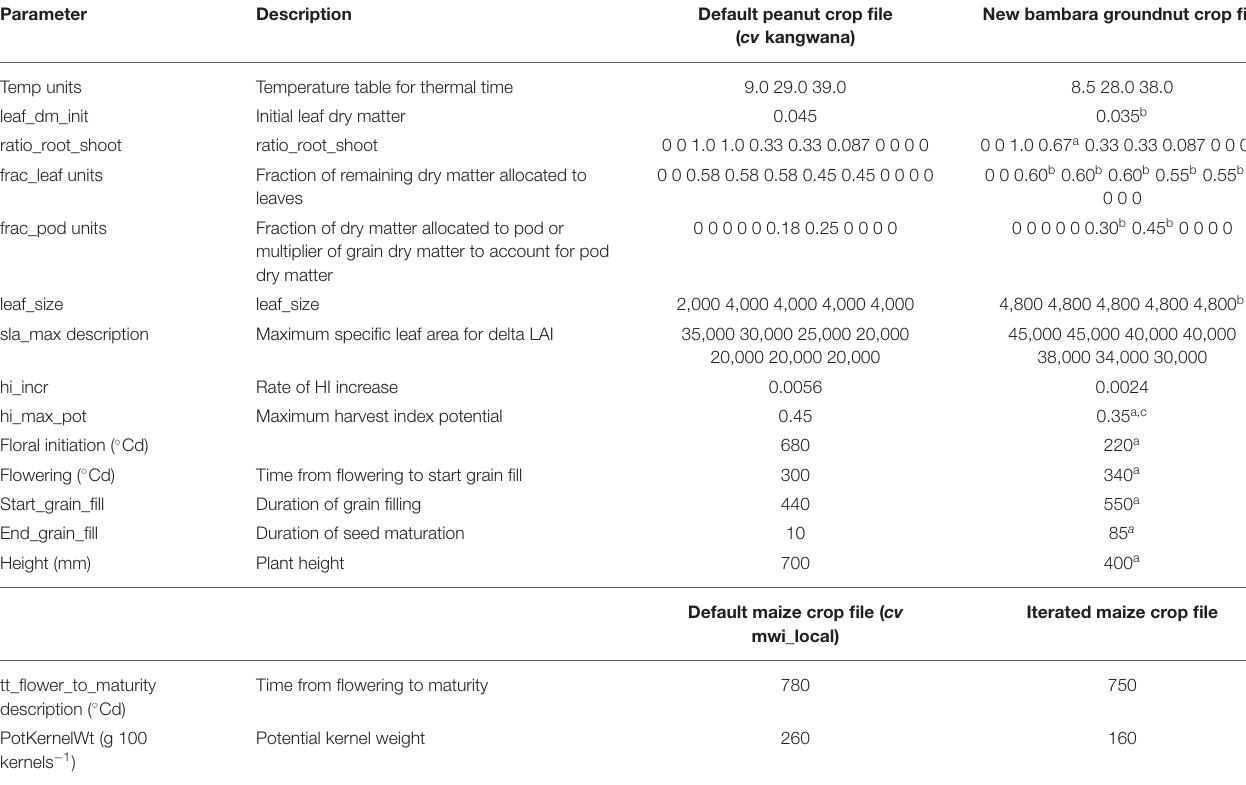
TABLE 2 | Modification of groundnut crop coefficients based on experimental data and data obtained from the literature.